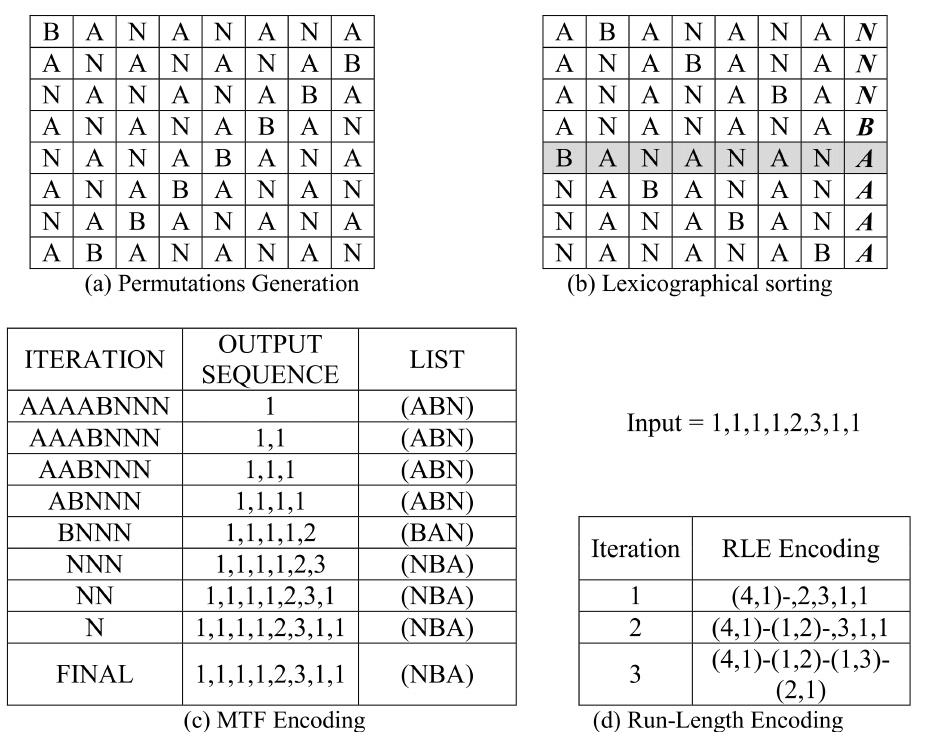
Figure 1. The classical Burrows–Wheeler Compression Algorithm (BWCA) [17].